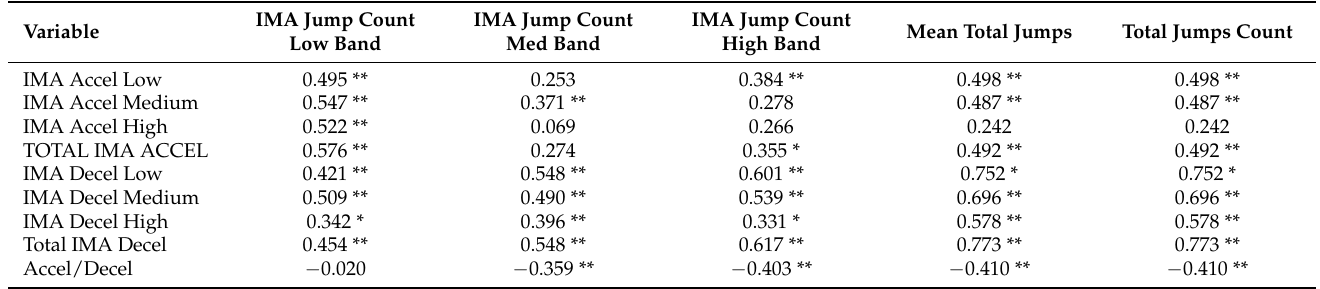
Table 5. Comparison of jump count and acceleration and deceleration count in given ranges during volleyball training.